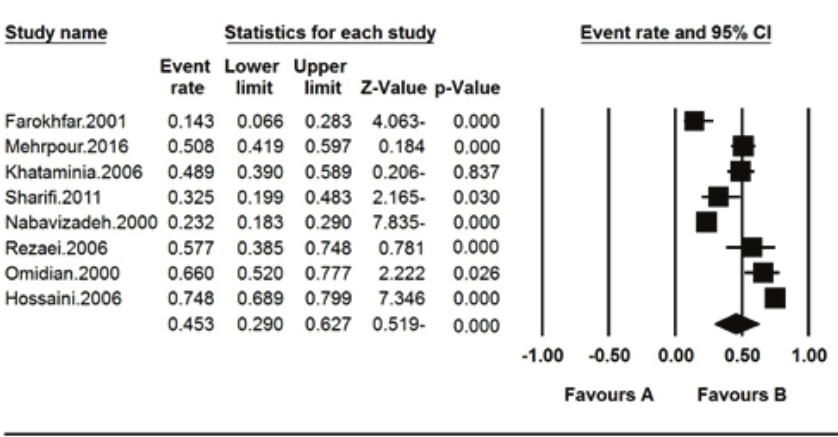
Figure 7. The prevalence of green color blindness (Dutan) in Iranian students.